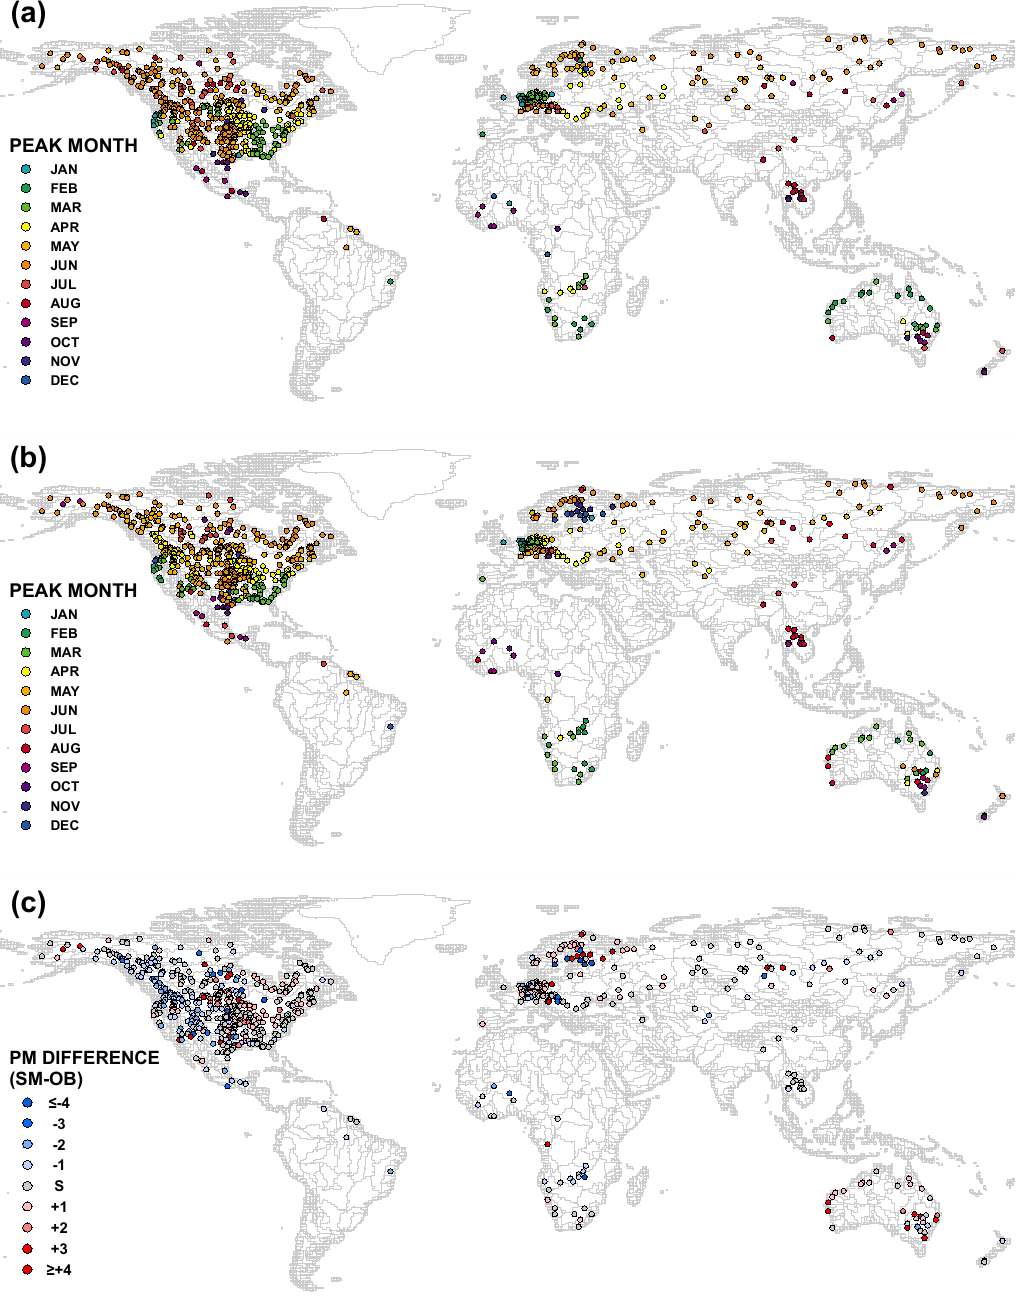
Figure 4. Peak month (PM) for flooding as defined by (a) 691 GRDC observation stations, (b) simulated streamflow at associated locations and (c) temporal difference in PM between observations and simulation (simulation–observation, in number of months; a negative (positive) value indicates that the simulated PM is earlier (later) than the observed